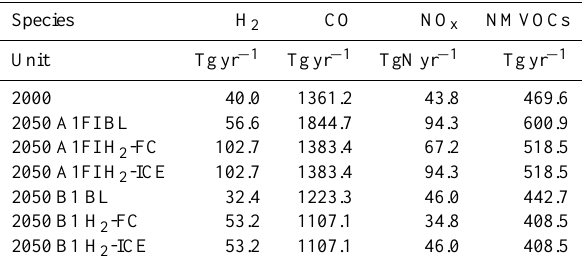
Table 1. Annual mean global emissions of key species for the sce- narios developed for this